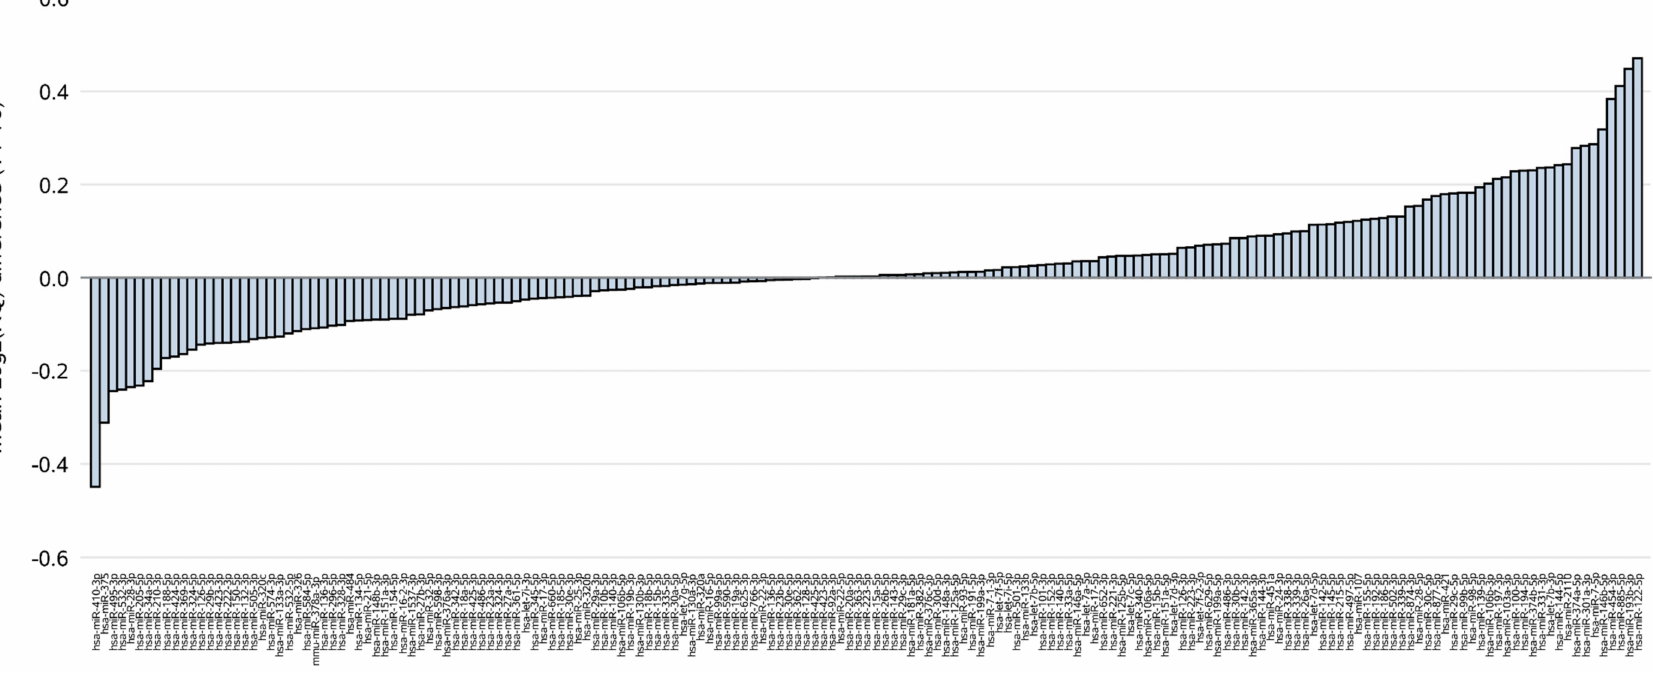
Figure 1. Waterfall plot of the mean di ff erence between week 2 (T1) and baseline sample (T0) for the 177 considered ct-miRNAs. ct-miRNAs on the x-axis are sorted according to the mean change between T1 and T0 samples expressed as log 2